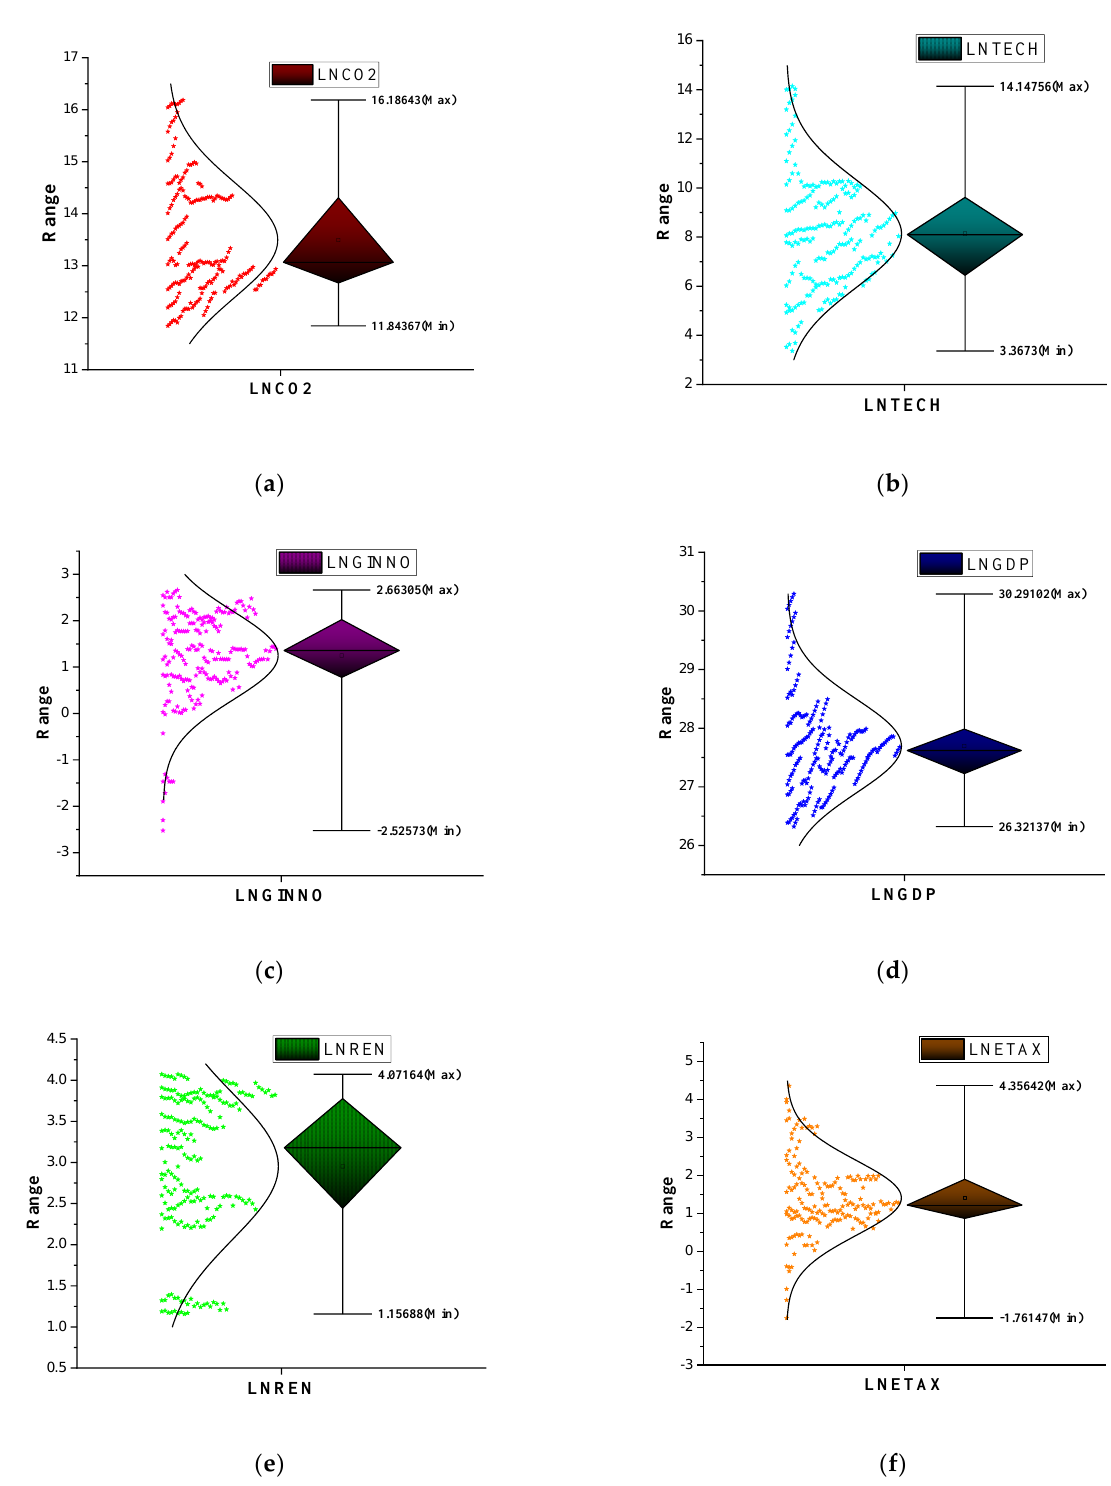
Figure 4. Box plot summary for the investigated variables: ( a ) LNCO2; ( b ) LNTECH; ( c ) LNGINNO; ( d ) LNGDP; ( e ) LNREN; ( f ) LNETAX.